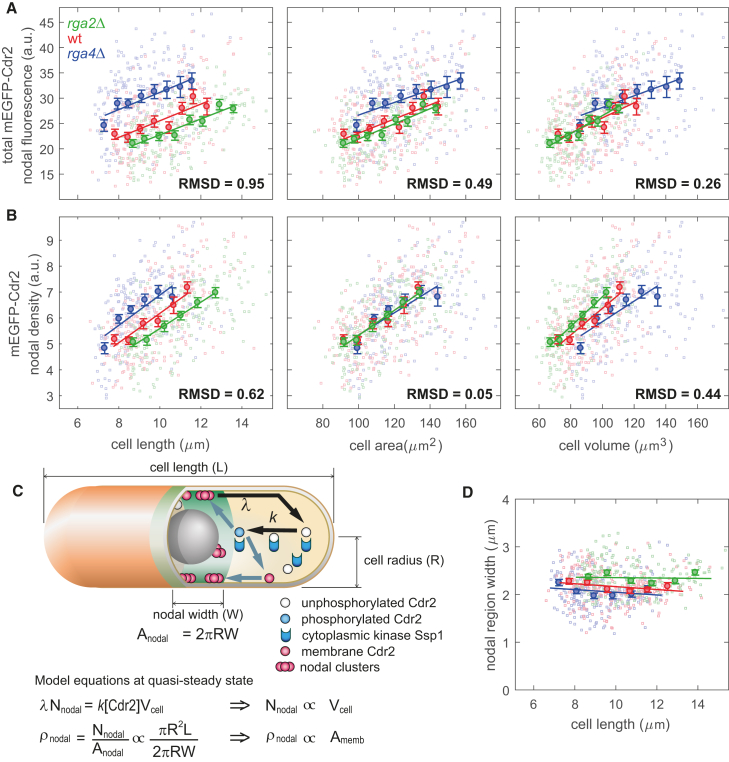
Density of Cdr2 in the Nodal Region Scales with Cell Surface Area, in Agreement with Results from Mathematical Model(A) Plots of total nodal intensity of mEGFP-Cdr2 for rga2Δ, wild-type, and rga4Δ strains as function of length, surface area, and volume.(B) Plots of nodal density of mEGFP-Cdr2, otherwise as in (A).(C) Sketch and equations of minimal model to explain Cdr2 nodal density scaling with cell surface area in wild-type (STAR Methods). Symbols: [Cdr2], cytoplasmic concentration of Cdr2; Nnodal, total nodal amount (fluorescence) of Cdr2; ρnodal, nodal density of Cdr2;k, kinetic parameter of Cdr2 phosphorylation by cytoplasmic Ssp1; λ, kinetic parameter of Cdr2 dissociation from nodes; Vcell, cell volume;Amemb, total membrane surface area; Anodal, nodal area with constant width W (see D).(D) Plot of nodal region width as function of cell length for rga2Δ, wild-type, and rga4Δ.Color legend: rga2Δ (FC3187; green; n = 211), wild-type (FC3156; red; n = 224), and rga4Δ (FC3189; blue; n = 201). Binned data (with mean value ± SE) and associated regression line are also shown in (A), (B), and (D). Normalized RMSD (between binned data; STAR Methods) also stated in (A) and (B): t tests on normalized RMSDs all give p values < 10−15.See also Figure S2.